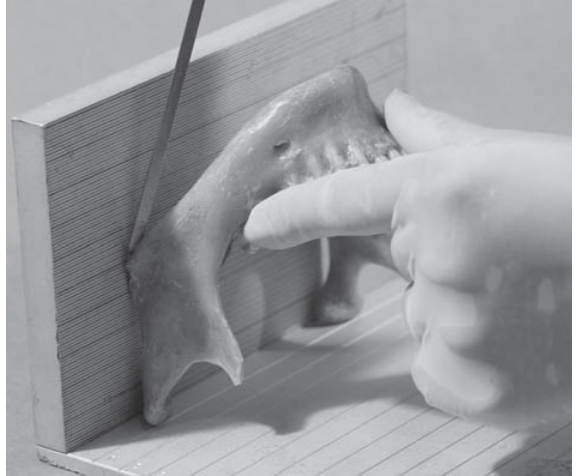
Figure 1- Measurement of bigonial diameter or bigonial width Figure 2- Measurement of mandibular ramus